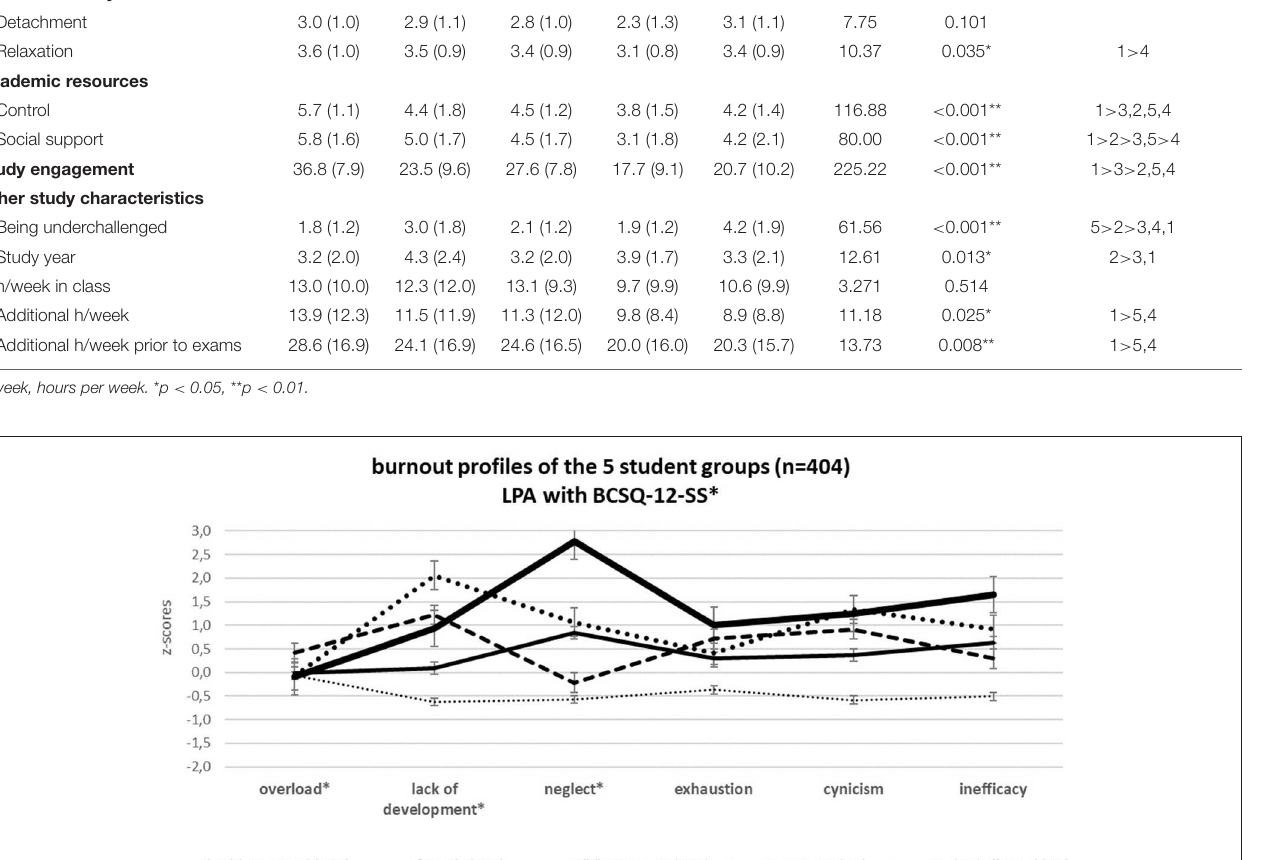
be most appropriate, because in the 2-class, 3-class, and 4-class solution, meaningful groups were missing. The five groups were ( Table 7 , Figure 3 ).